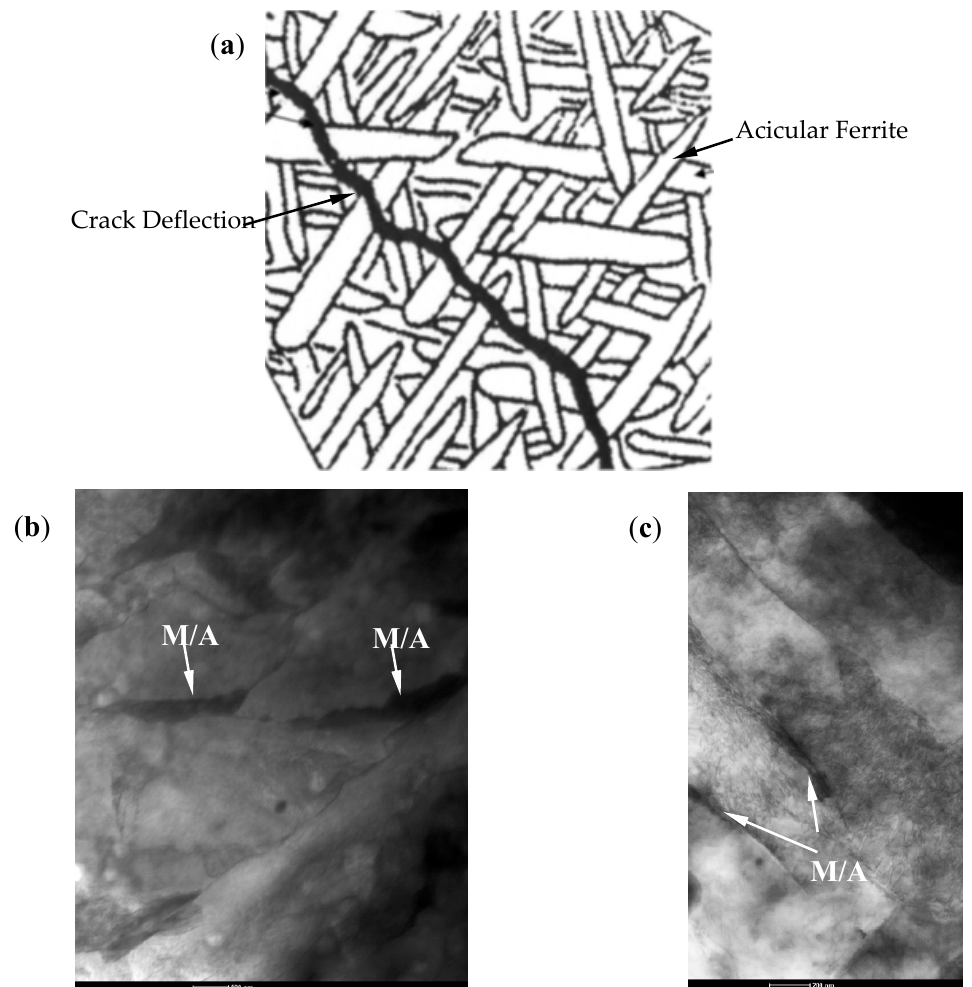
Figure 4. ( a ) Schematic feature of cleavage crack deflection at the lath boundaries of acicular ferrite [15]. ( b , c ) TEM micrographs of acicular ferrite developed under the processing parameters: FRT = 780 °C, a = 20 K·s − 1 , CT = 350 °C. The AF in ( b ) is of crossing interwoven ferrite laths and in ( c ) is of parallel ones.